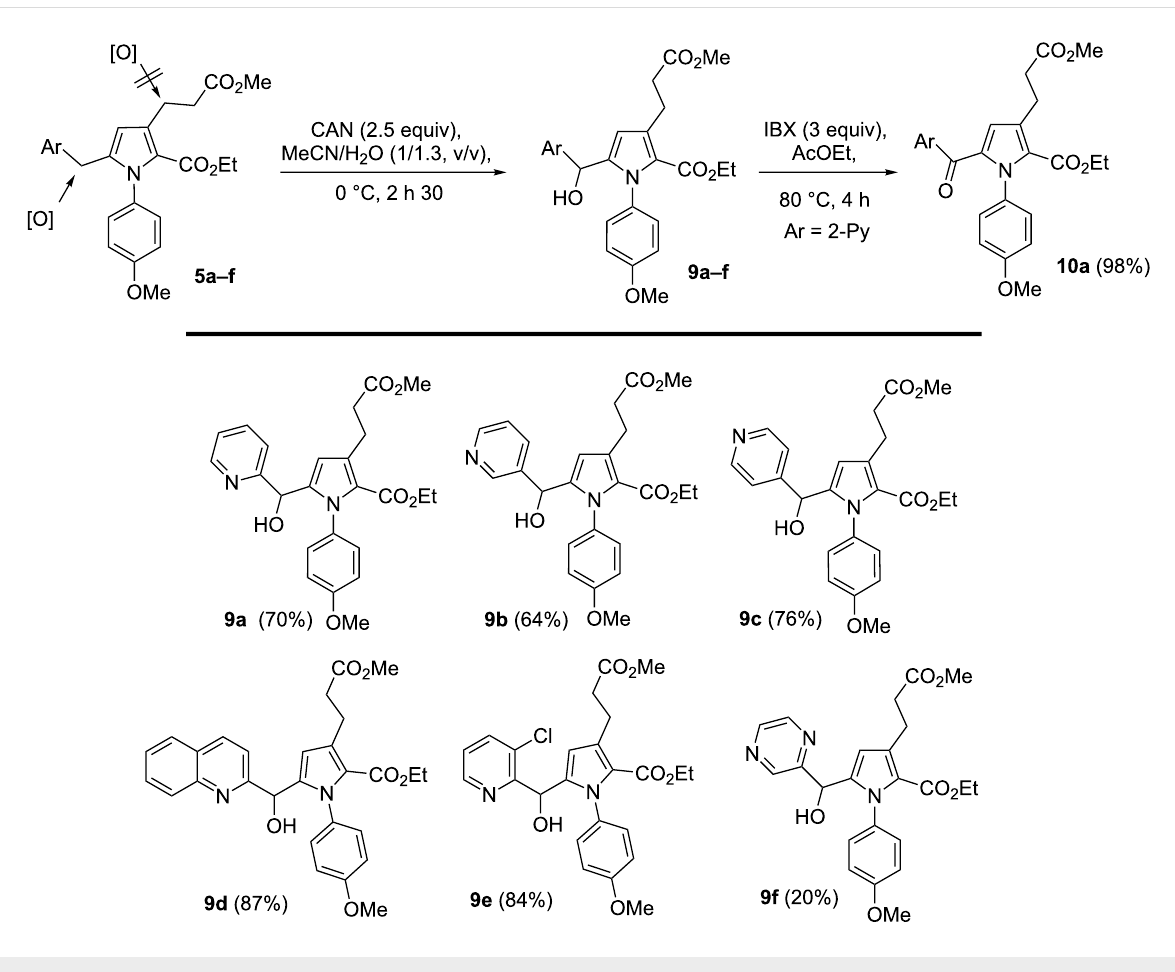
Scheme 6: Bis(heteroaryl)methylene oxidation of 5a–f